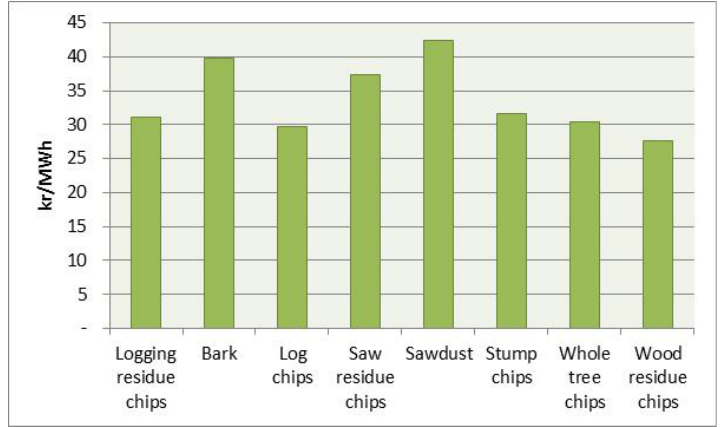
Figure 19. Rail costs for different